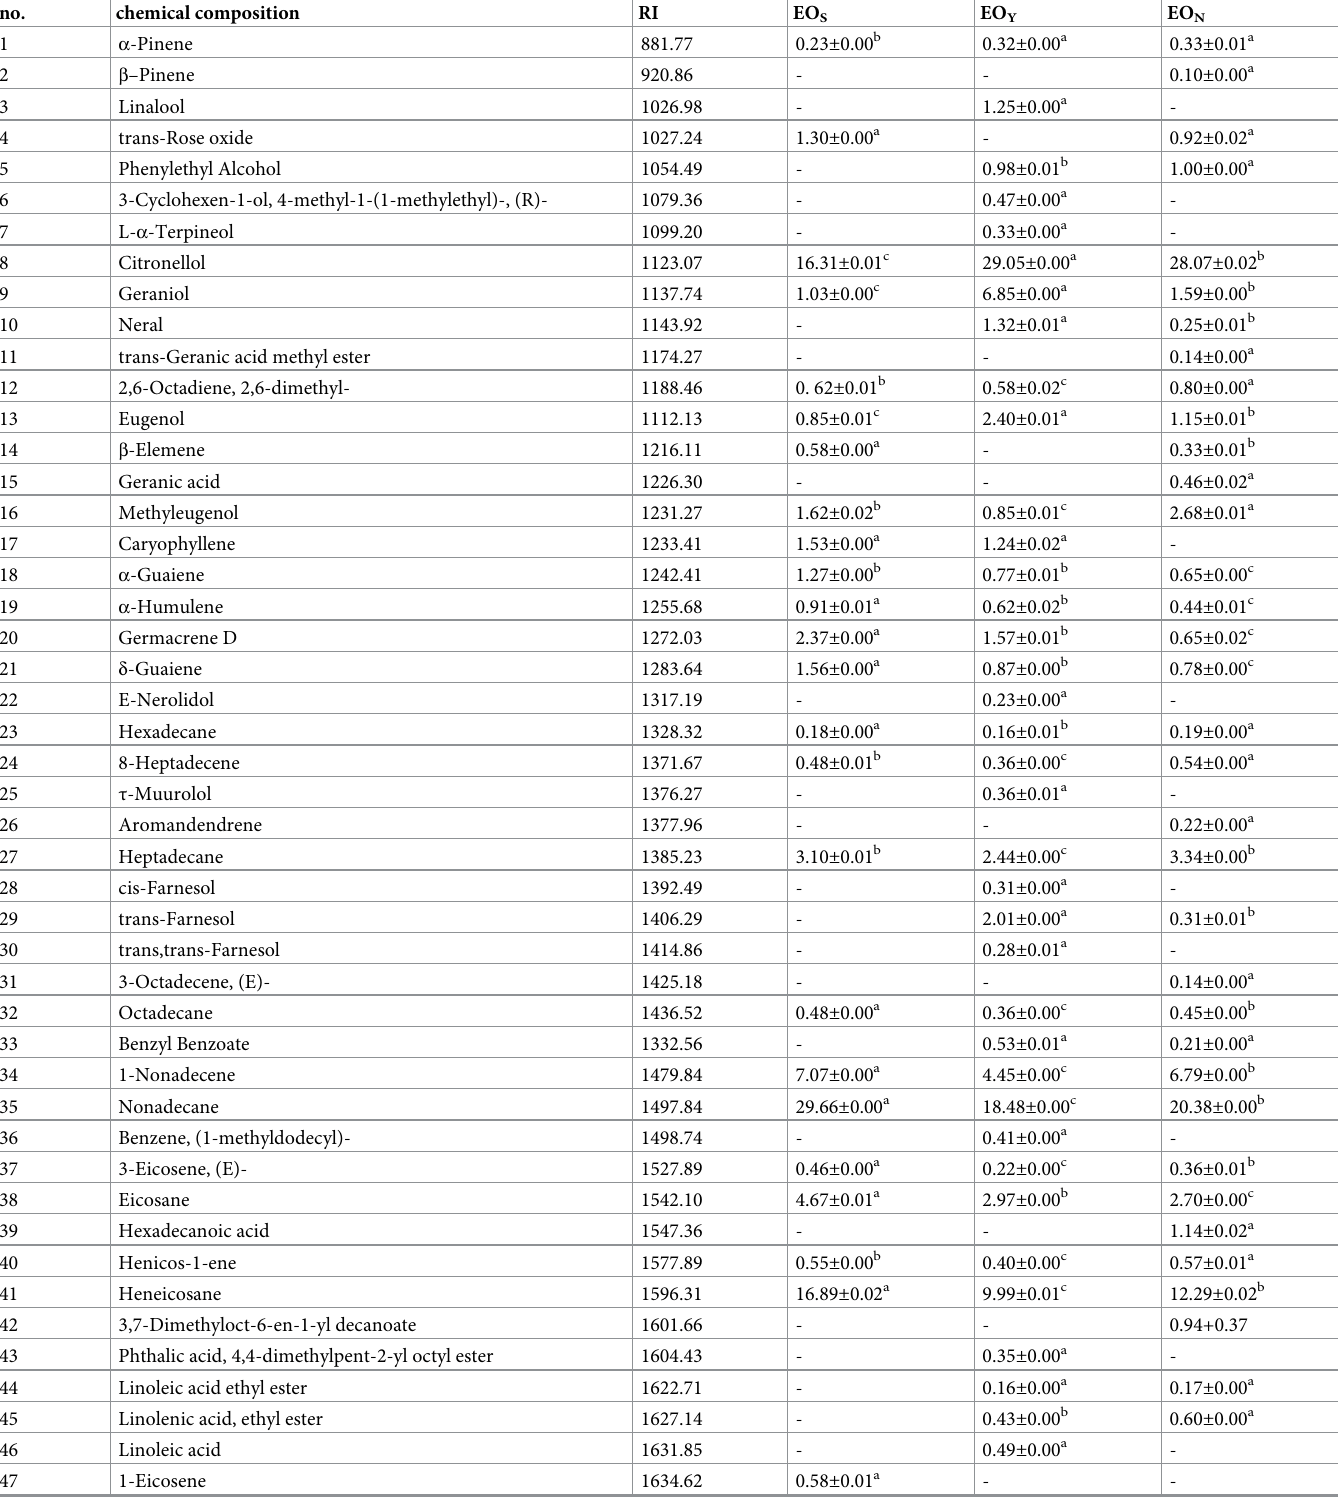
Table 7. Diversity in chemical composition of R . damascena EO at the crop